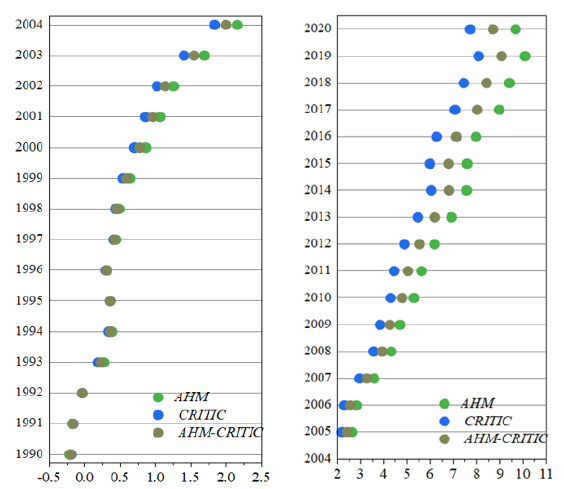
Fig. 6. Calculation results of the financial development index of Beijing by different models.